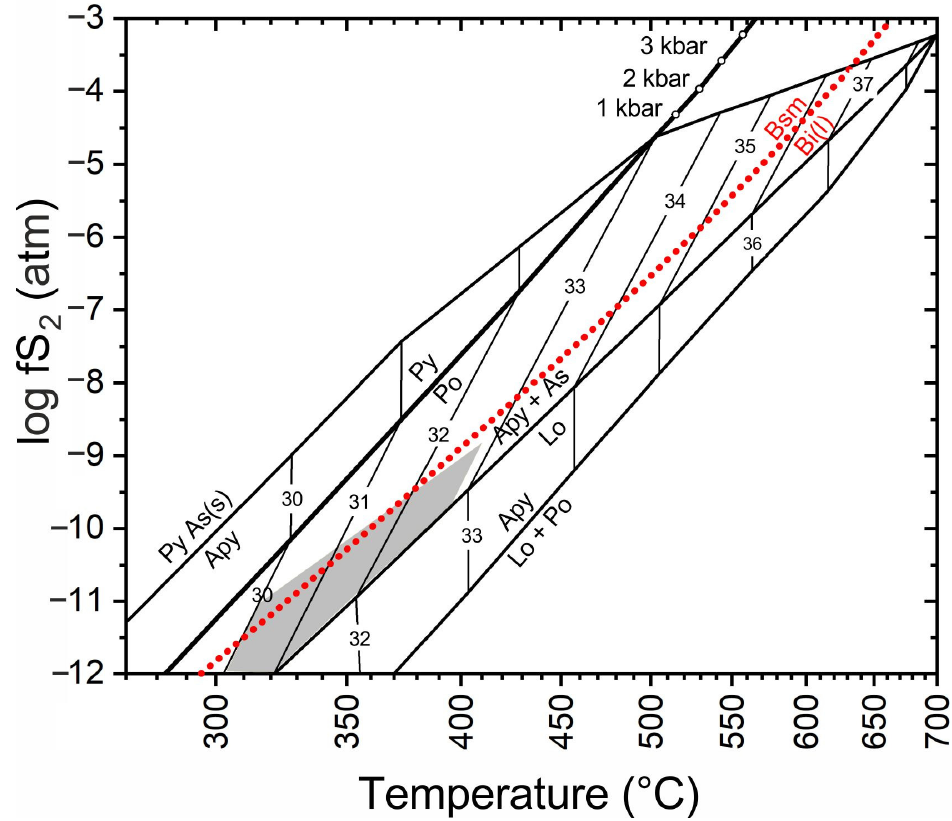
Figure 27. Phase diagram of the Fe-As-S system showing the correlation between the As content of arsenopyrite (at. %) and temperature and sulfur fugacity. The red dotted line shows the stability of bismuthinite (Bsm) and liquid bismuth (Bi (l)). The shaded field indicates estimated conditions of formation of arsenopyrite from the studied vein, based on the most typical range of As (at. %) con- tent.